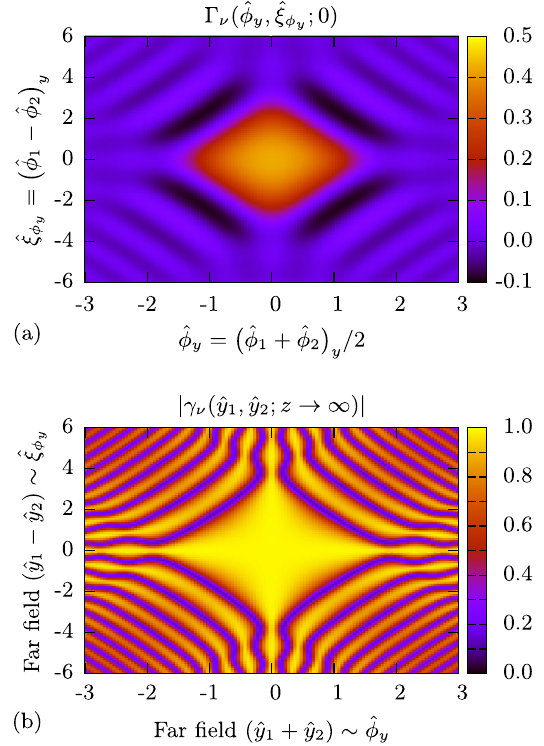
FIG. 4. Coherence functions in the limit ˆ ε → 0 . Panel (a) plots ~ Γ W ϕ ξ = 2 ; ϕ 1 − ξ = 2 Þ from (42). Panel (b) plots the ν ;y ¼ ν ð 1 þ y y magnitude of the spectral degree of coherence j γ ν j in the far field where z → ∞ . Since γ ν in the far field is essentially the Fourier transform of the near field γ ν , (a) and (b) can be directly compared.